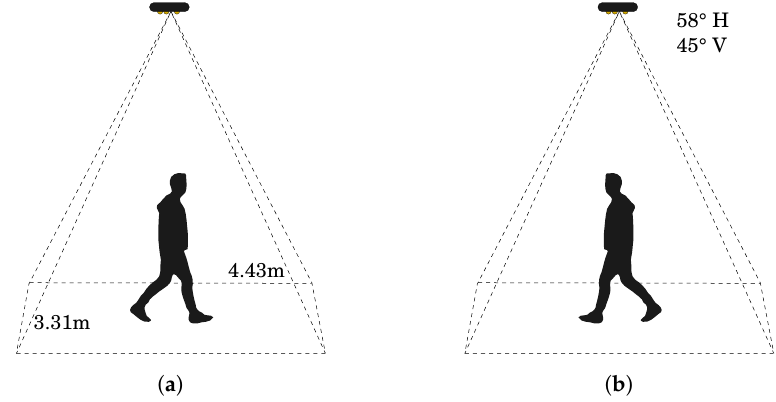
Figure 1. System architecture. ( a ) represents the first passage under the camera as training set, ( b ) is the the returning in the initial position considered as testing